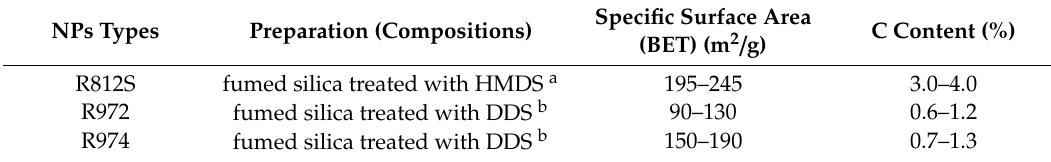
Table 1. Basic parameters of the commercial hydrophobic NPs, as reported by the